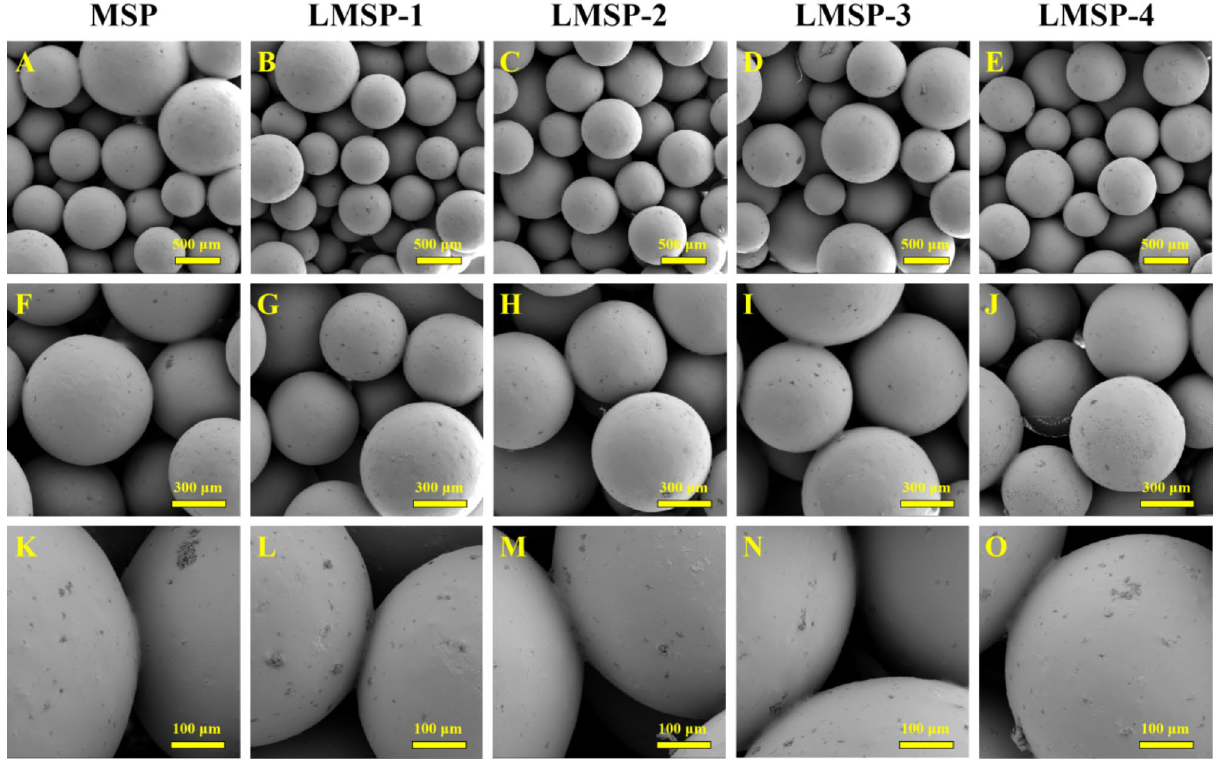
Figure 1. SEM images displaying similar morphology including the effective adhesion between microspheres of MSP and LMSP-1–4 microsphere-based scaffolds prepared in this